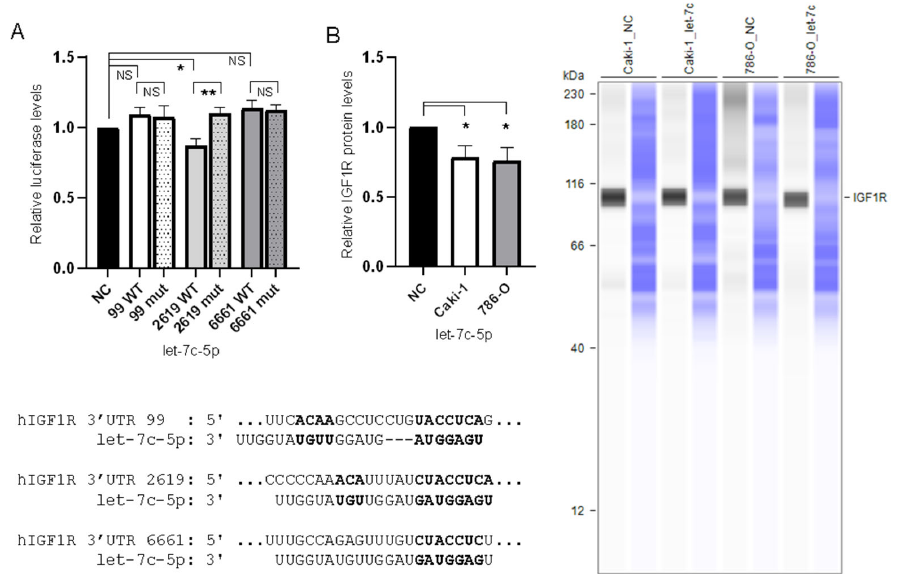
Figure 3. The effect of let ‐ 7c ‐ 5p on the expression of IGF1R. ( A ) Relative luciferase activity of Caki ‐ 1 cells for each vector, including mutants, transfected with pre ‐ let ‐ 7c ‐ 5p, relative to the negative control transfectant (predicted sites detailed in the inset below the chart). ( B ) Relative expression of IGF1R in Caki ‐ 1 and 786 ‐ O cells transfected with let ‐ 7c ‐ 5p after 48 h, relative to the negative control for each cell line. Representative image inset to the right: the first lane of each pair corresponds to IGF1R and the second is total protein detected for the same lane. * p < 0.05, ** p < 0.01, and NS = not significant.